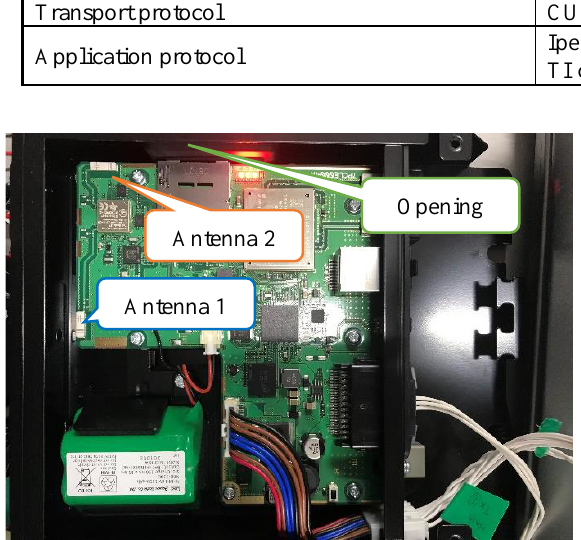
Figure 1. Communication device: It is implementing on the cabin of the excavator.